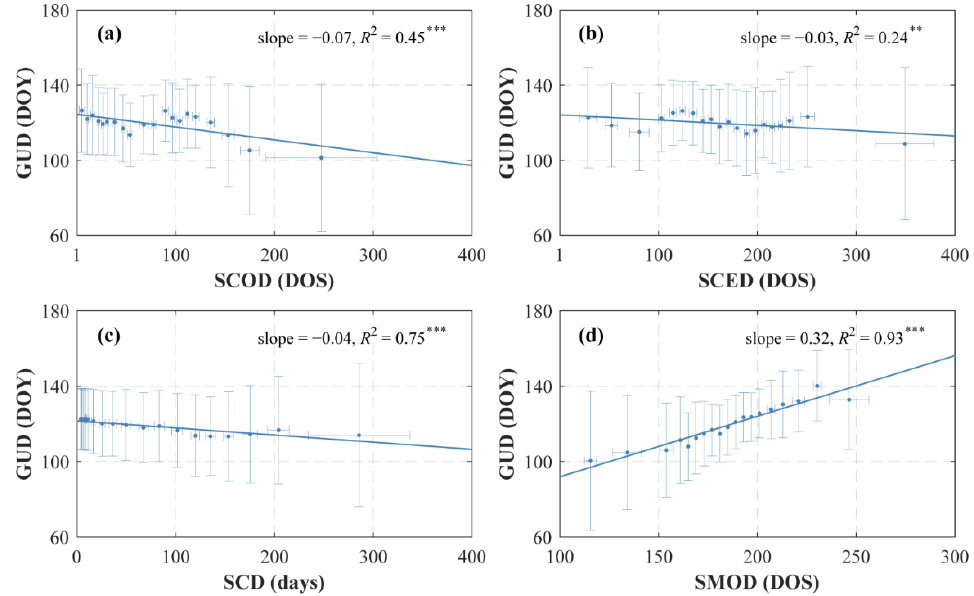
Figure 6. Sensitivity of GUD to snow cover phenology metrics, i.e., ( a ) SCOD, ( b ) SCED, ( c ) SCD, and ( d ) SMOD, for the pixels with a significant correlation ( p < 0.01). Points are the average GUD and a certain metric of snow cover phenology based on quantile discontinuities of snow cover phenology for the pixel-years. The horizontal and vertical error bars represent the standard deviations of snow cover phenology and the GUD, respectively. The lines are linear regression models of those points, and the slopes of the lines represent the sensitivity. The symbols ** and *** are significant at the levels of 0.05 and 0.01, respectively.